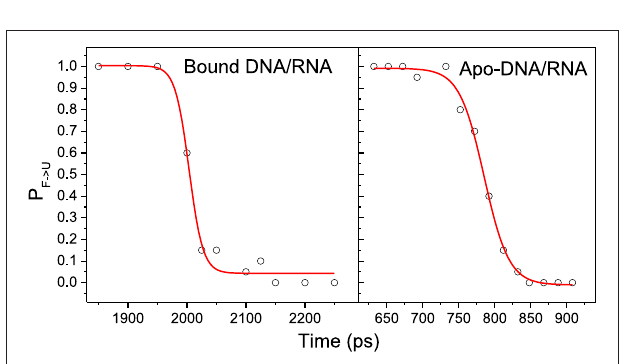
analysis yields 50 snapshots for the bound DNA/RNA and